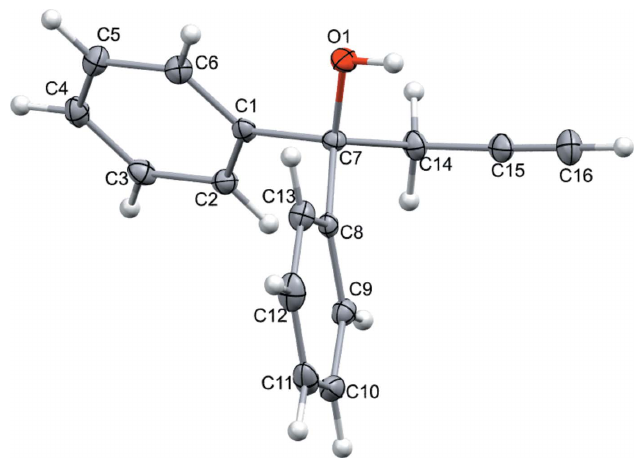
Figure 1 The title molecule with 50% probability